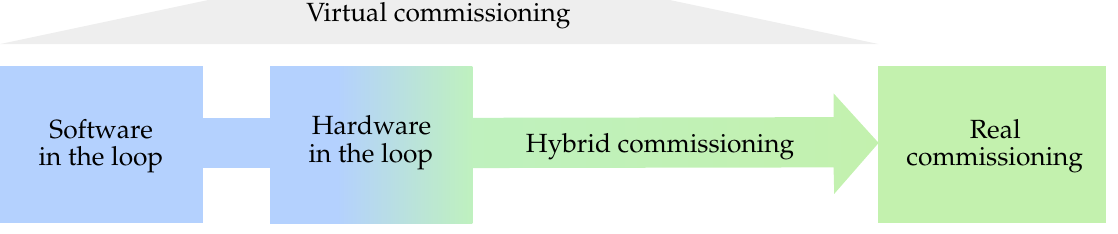
Figure 2. Variants of virtual commissioning. Reproduced with permission from authors of [15].